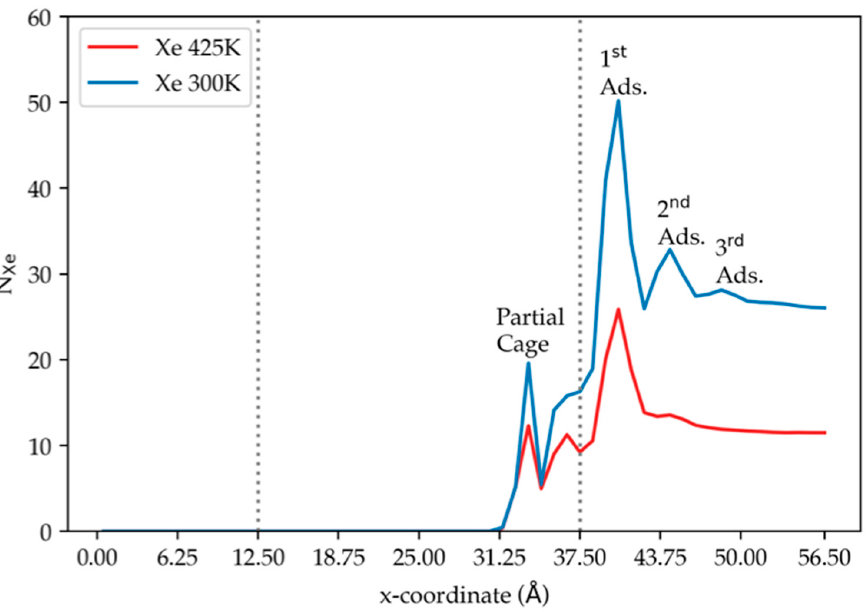
Figure 10. The density profile of xenon along the direction normal to the membrane surface at two pressures, using results from simulation (5) and (6) at 150 atm. The dashed vertical lines correspond to the membrane edges.